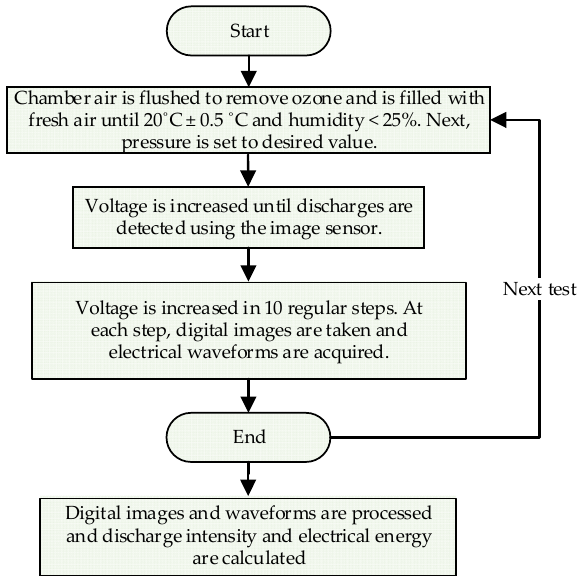
Figure 4. Flow diagram of the experimental measurements.